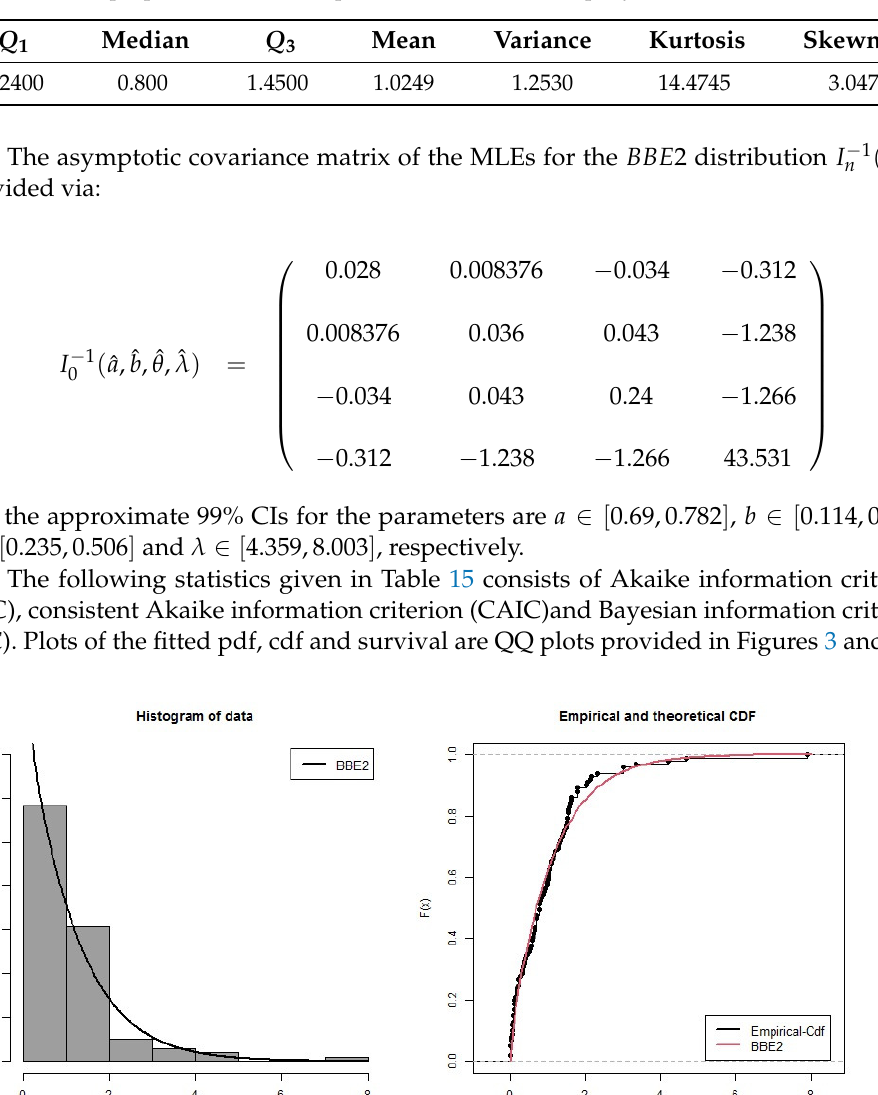
Table 14. Some properties of Stress-Rupture Life of Kevlar 49/Epoxy Strands Data.